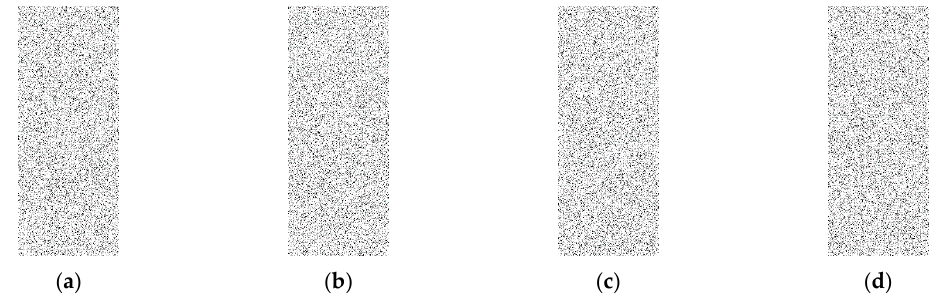
Figure 6. Rate is 0.15, ( a ) is the completely random cases; ( b ) is DUD scenarios; ( c ) is DAD scenarios and ( d ) is CAD scenarios, and all images look very similar to each other.